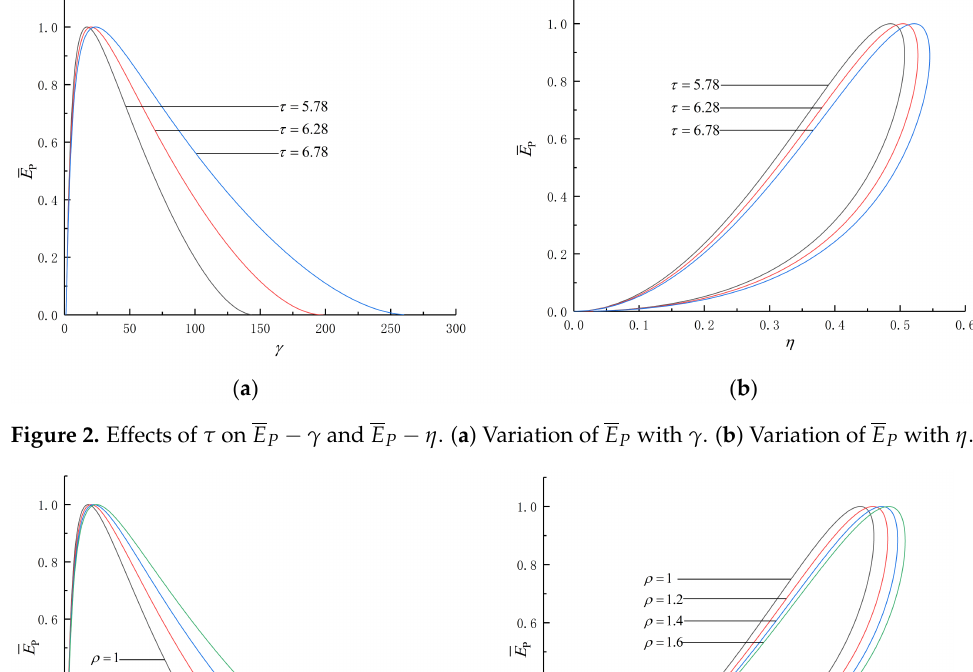
Figure 3. Effects of ρ on E P − γ and E P − η . ( a ) Variation of E P with γ . ( b ) Variation of E P with η .